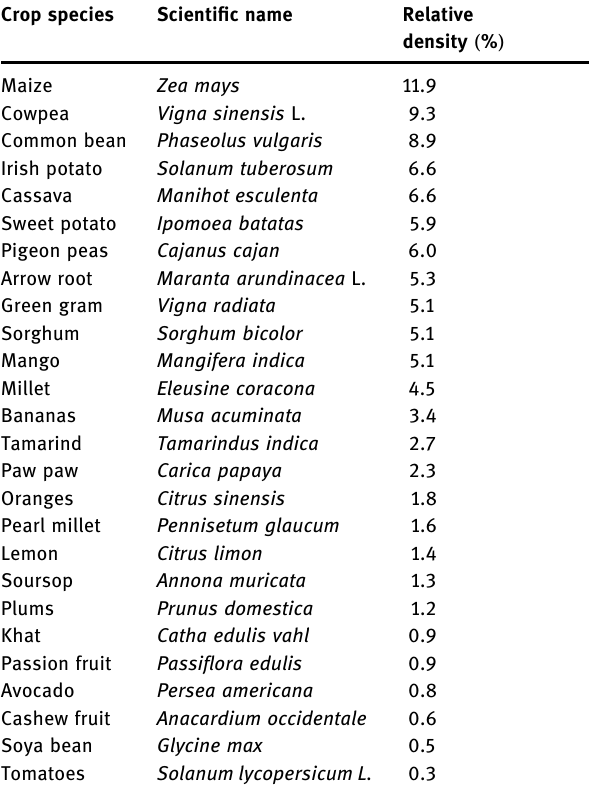
livestock rearing. There was also a signi fi cant positive correlation between livestock keeping and reserve food ( p < 0.05, r = 0.416 ) .